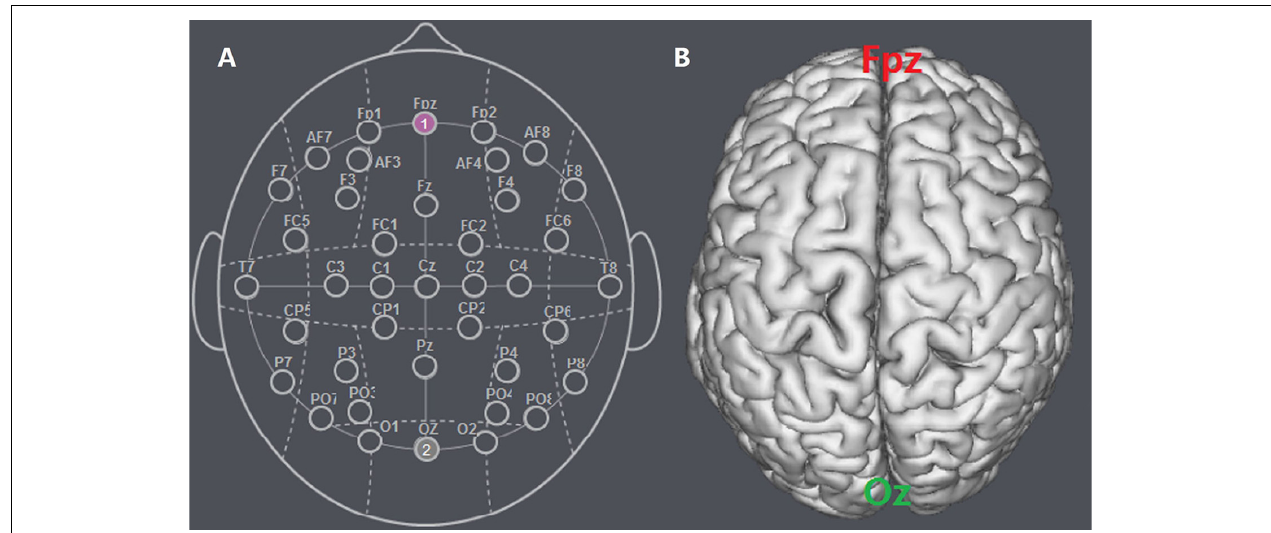
FIGURE 1 | Schematic and locations of the electrode positions. (A) Schematic of the electrode positions Fpz and Oz based on the international EEG 10-20 system. (B) Locations of the MPFC and the visual cortex (Oz) of the human brain.